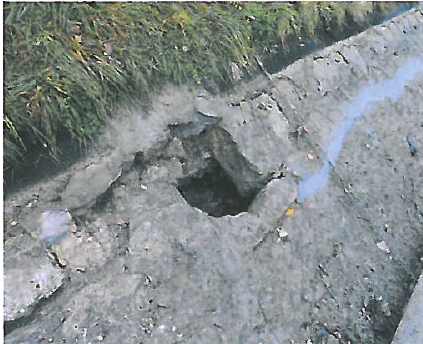
Figure 5: Example of serious undermining by internal erosion in the upper part of the paved revetment.